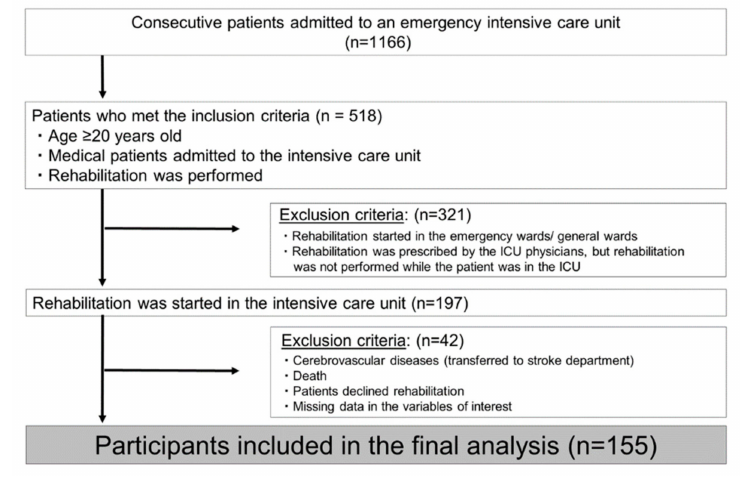
Figure 1. Flow of patient